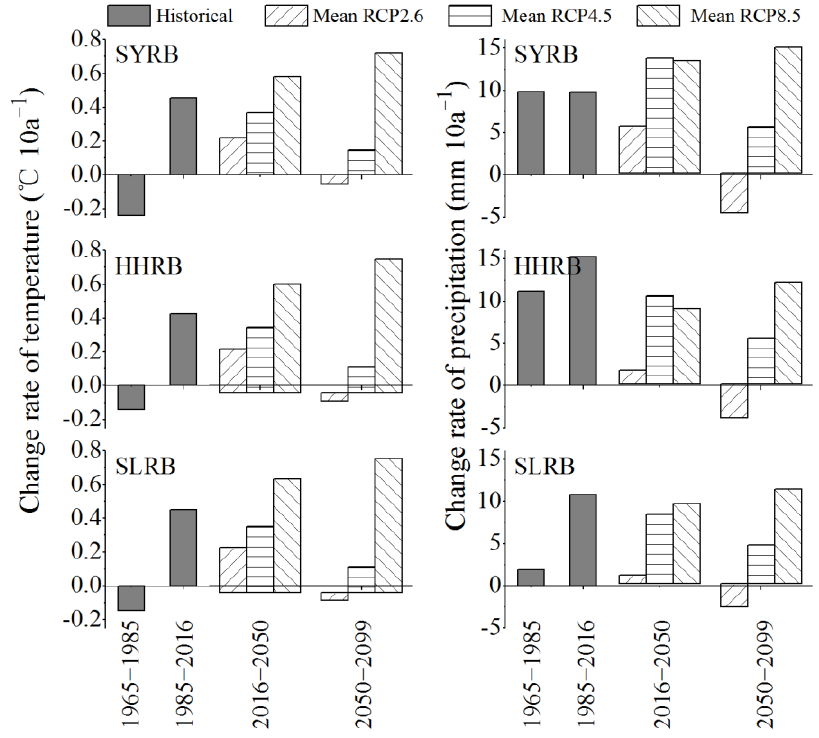
Figure 5. Change rate of temperature and precipitation during 1965~2055 in three basins.